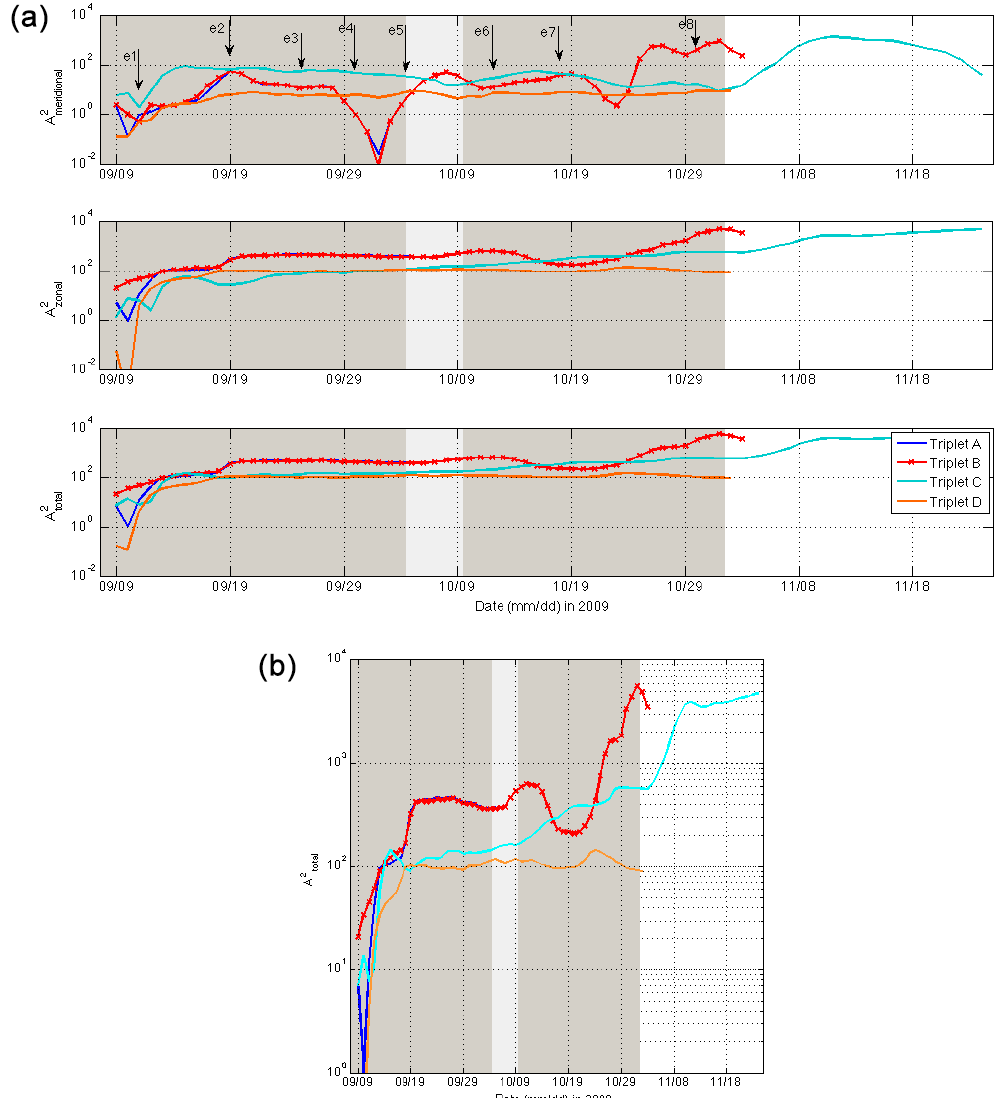
Figure 4. Absolute (single-particle) dispersion statistics for beacons comprising triplets A (blue), B (red), C (cyan), and D (amber), de- picting meridional (top), zonal (middle), and total (lower) dispersion, providing a local characterization of ice drift at varying distances from the coastline. (a) Triplets A and B, located closest to the coastline, exhibit considerable meridional variability relative to triplets C and D (upper panel in Fig. 4a). Single-particle displacements are also shown to decrease with increasing distance from the coastline. (b) Total single-particle dispersion for triplets A (blue), B (red), C (cyan), and D (amber) as an enlargement of lower panel in Fig. 4a capture temporal evolution in and differences between triplet slopes based on local beacon behaviour associated with each triplet. Total absolute dispersion is governed by zonal dispersion. Furthermore, inflection points in absolute dispersion associated with the local characterization capture transitions in dynamical regimes due to changes in local ice conditions. Shading and arrows are as in Fig. 3, providing a regional